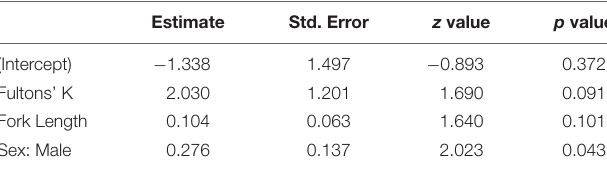
TABLE 1 | Parameter estimates for the binomial prevalence GLM where individual infection status (i.e., infected or uninfected) is the binary response variable. Estimate Std. Error z value